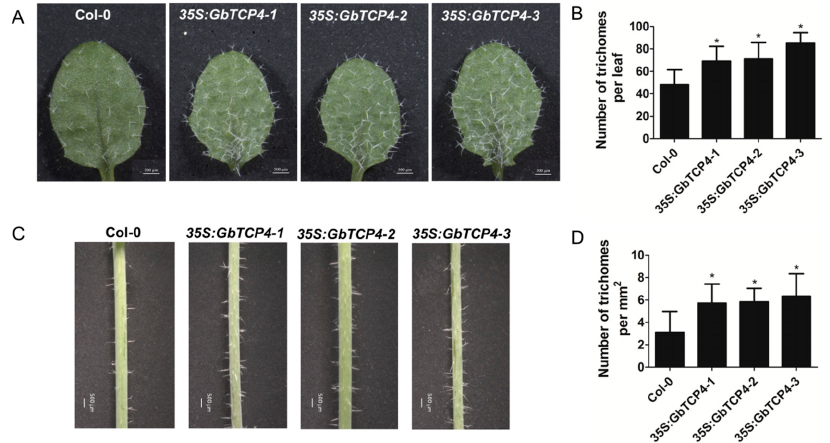
Figure 5. Constitutive overexpression of GbTCP4 in Arabidopsis affects trichome formation. ( A ) Leaf trichome phenotype from the first two rosette leaves of 2-week-old soil-grown seedlings of the Col-0 and 35S:GbTCP4 transgenic lines. Scale bars: 500 µm. ( B ) Comparison of the trichome number on the first two rosette leaves from Col-0 and 35S:GbTCP4 transgenic lines. ( C ) Stem trichome phenotype from the main stem internodes from the bottom of 1-month-old soil-grown seedlings of Col-0 and 35S:GbTCP4 transgenic lines. Scale bars: 500 µm. ( D ) Comparison of the trichome density on the main stem internodes from the bottom of Col-0 and 35S:GbTCP4 transgenic lines. Values are means (±SE) of 30 seedlings for each of three independent experiments. Asterisks indicate significant differences (* p < 0.05) relative to Col-0.